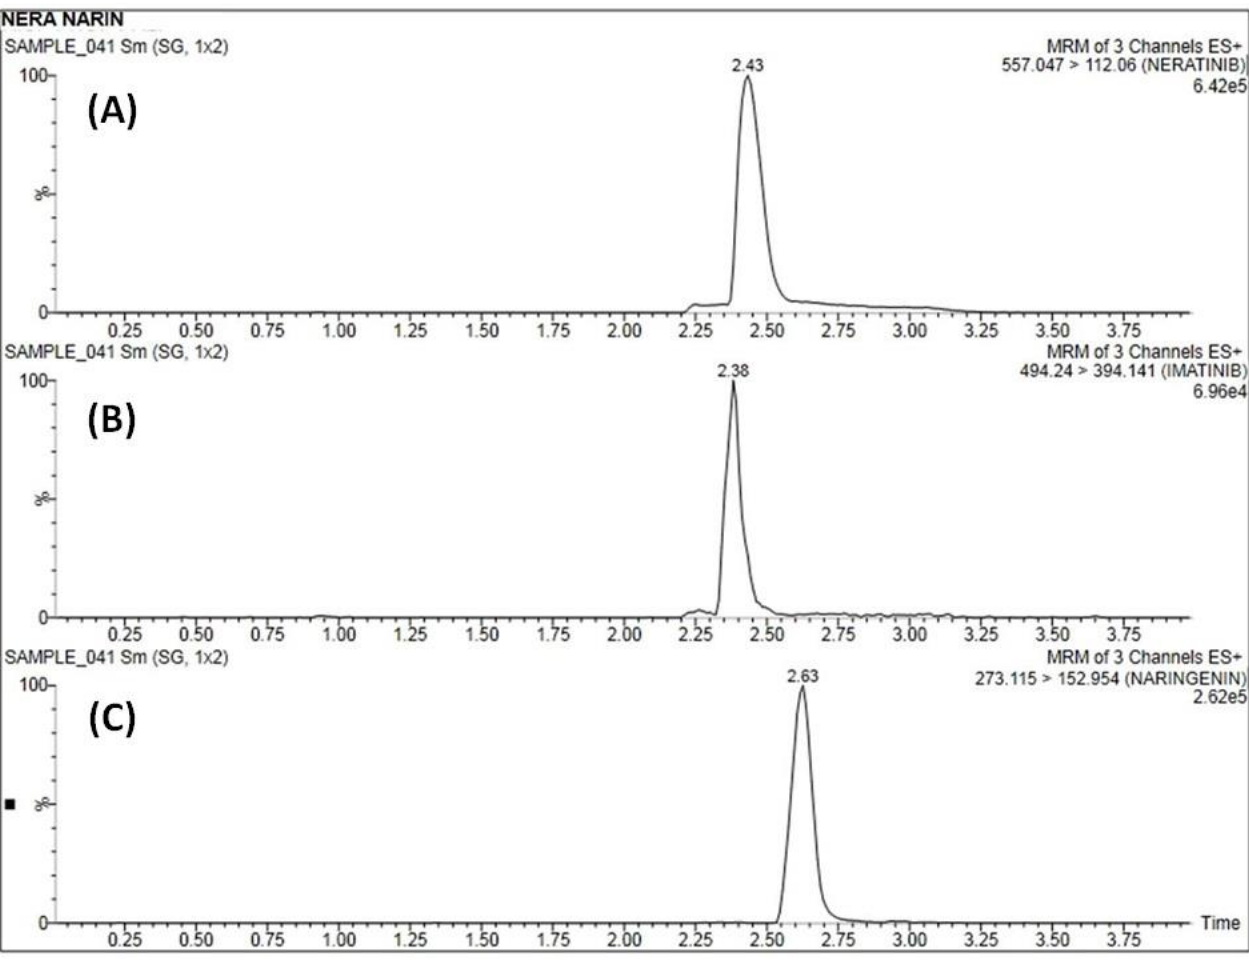
Figure 3. Calibration curve of NER and NRN.